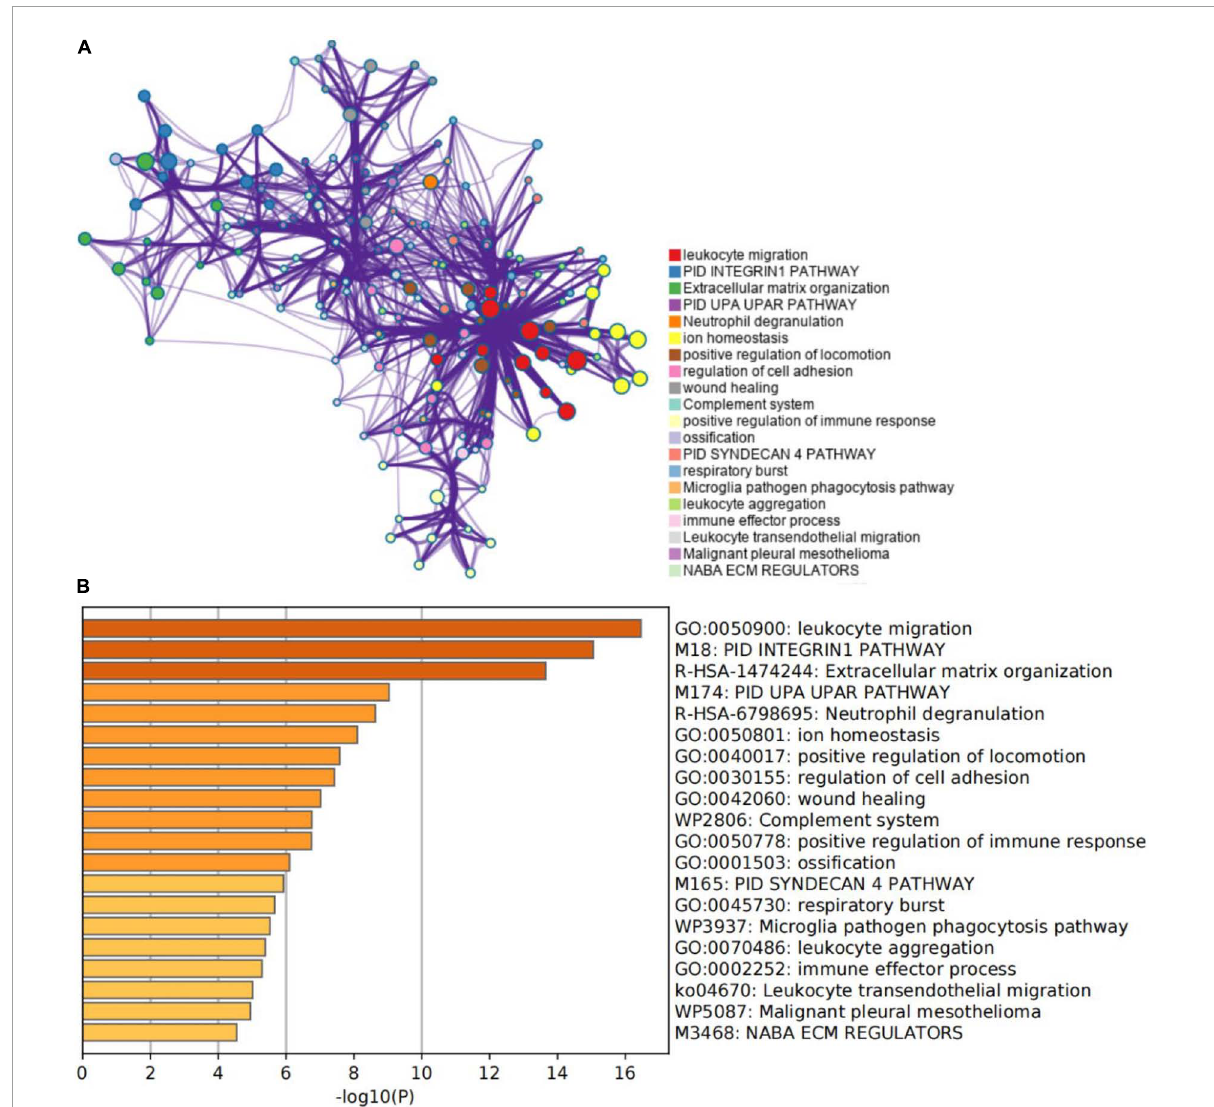
FIGURE3 Gene function enrichment analysis results. (A) The network of the top 20 enriched term clusters. The color indicates cluster identification, the thickness of the edge indicates the similarity score, and terms with a similarity score > 0.3 are connected by an edge. (B) The top 20 clusters are shown in a heat map. Color is used to indicate cluster identification; the lower the p-value, the darker the